Question: In a single sentence, describe what this figure presents.
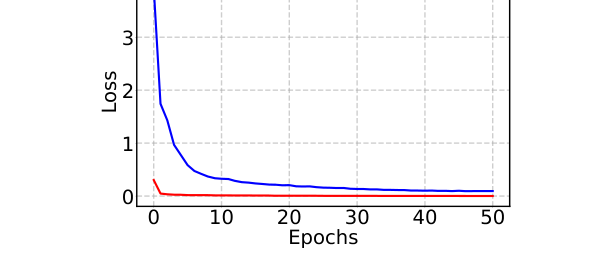
Answer: Training loss of a d-Simplex fixed classifier during a model update. Values are the cross-entropy loss of Eq. 2 (red line) and the loss of Eq. 3 (blue line). Models are trained on MNIST.